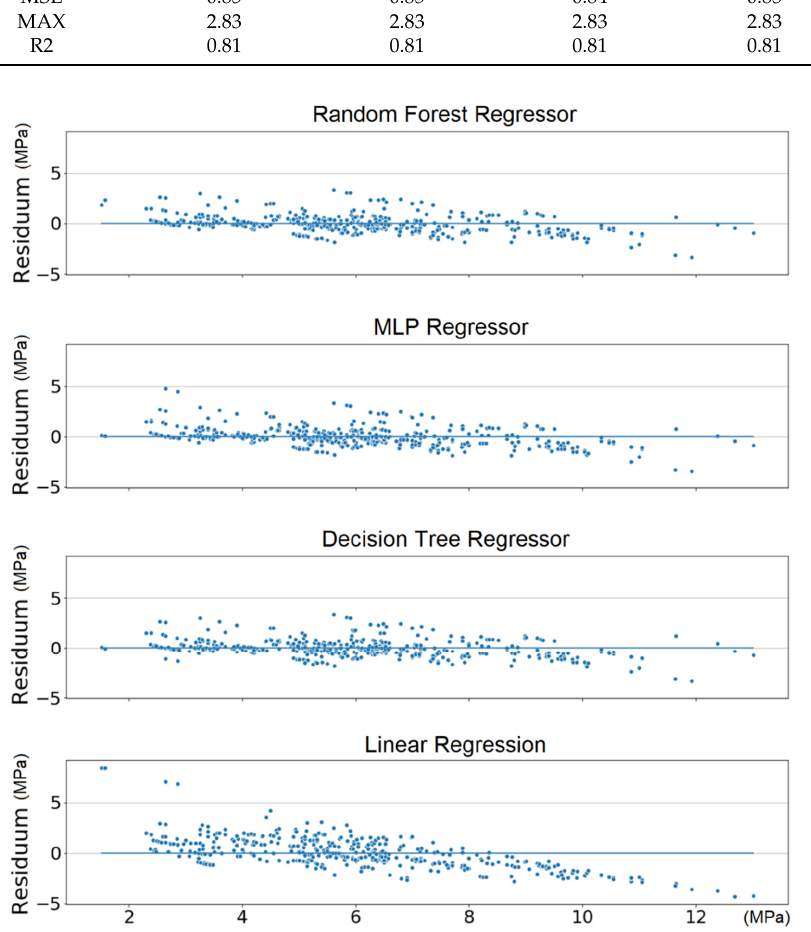
Figure 3. Comparison of residuals of the predictive models.